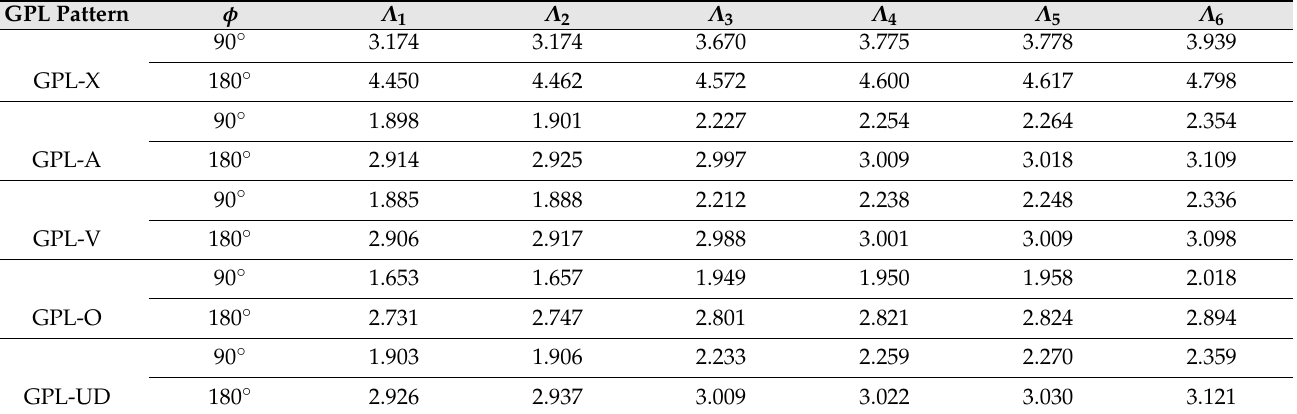
Table 3. Buckling loads (GPa) of FG-GPL, porous spherical caps for various polar angles and GPL patterns (PD3, e 0 = 0.2, γ = 0.01 wt%).